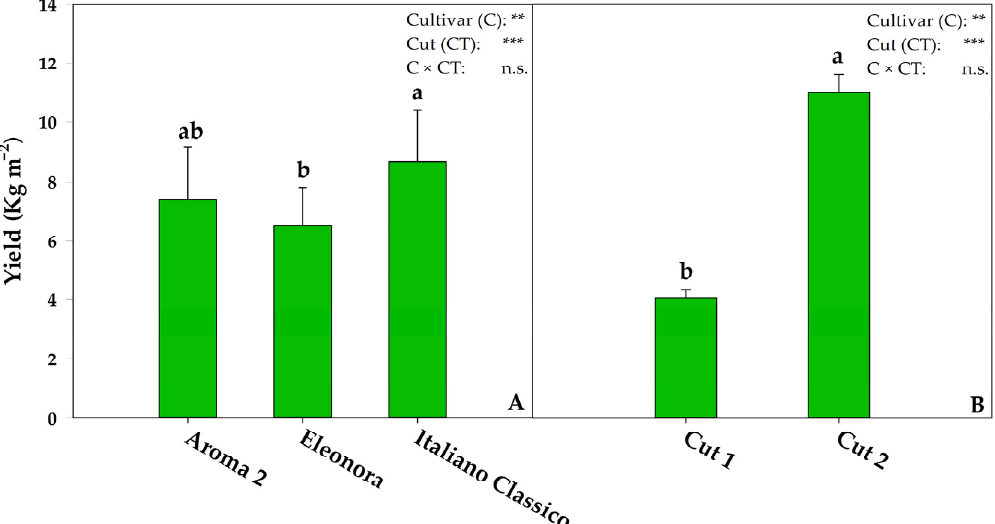
Figure 2. Effect of cultivar ( A ) and cut ( B ) on the yield of green Genovese basil. n.s., **, *** non-significant or significant at p ≤ 0.01 and 0.001, respectively. Cultivar means were compared by ANOVA; according to Duncan’s multiple range test ( p = 0.05), different letters indicate significant differences. Cut means were compared using a t -test. All data are expressed as mean ± standard error (SE) ( n = 3).